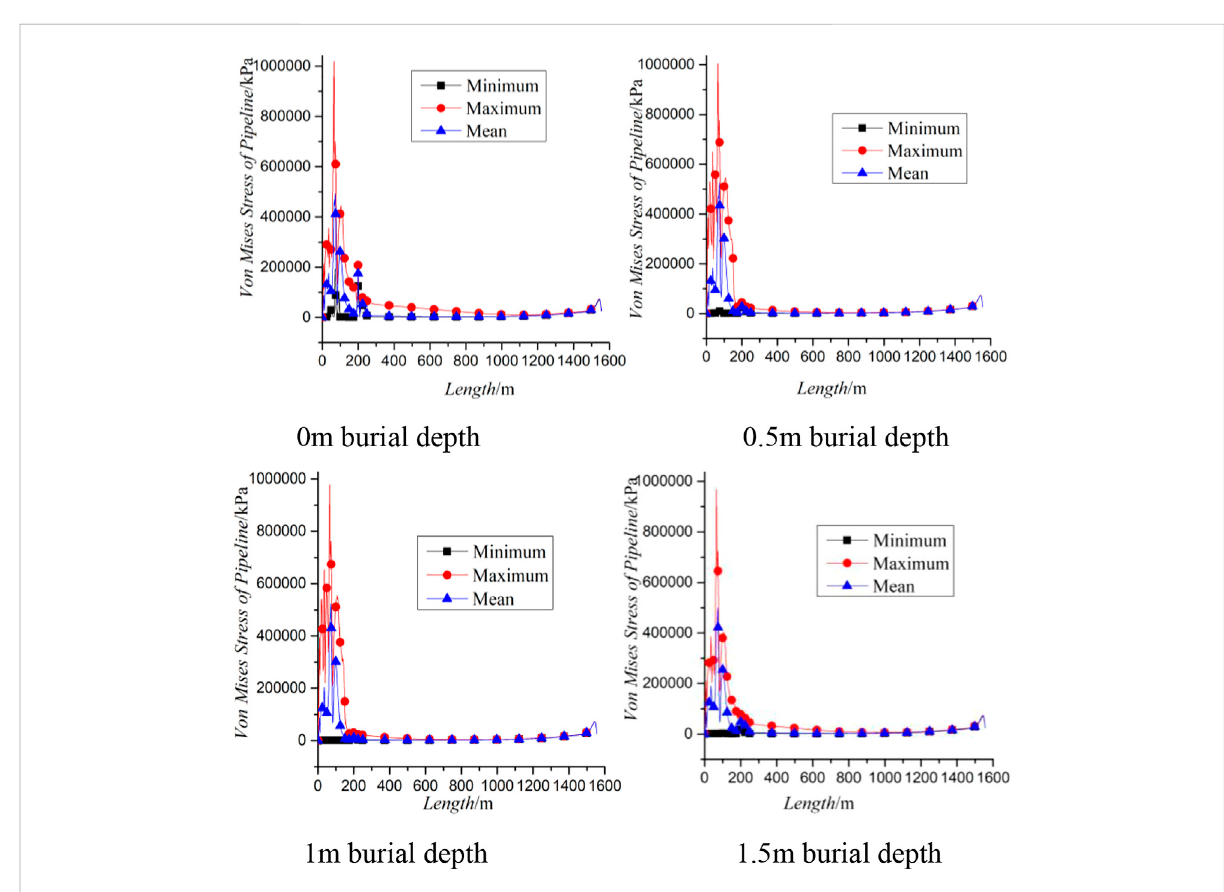
FIGURE 14 Von Mises stresses the pipeline in the length direction with different burial